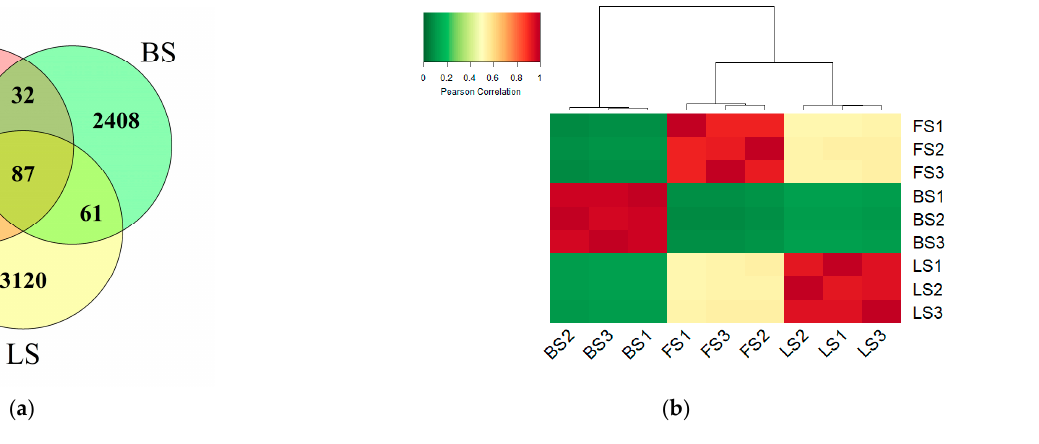
Figure 2. ( a ) Venn diagram showing the distribution of bacterial ASVs in different original soils; ( b ) Heatmap showing the Pearson correlation based on ASV abundances in the three original soils. FS: fluvo-aquic soil; BS: black soil; LS: loess soil.